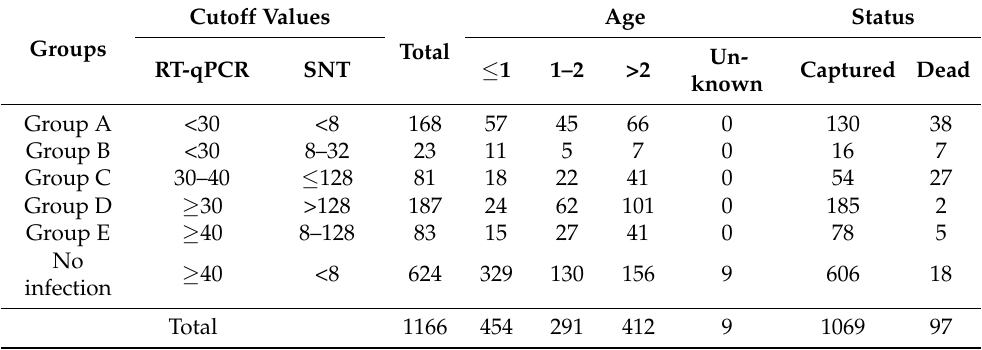
Table 2. Quantitative classification of the antigen and antibodies against CSFV.